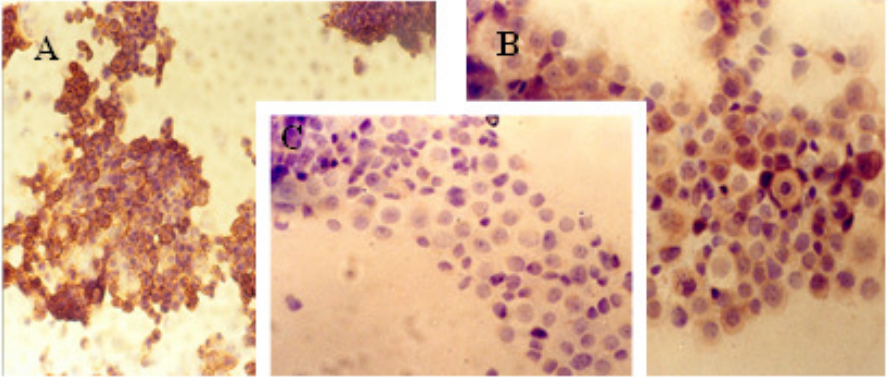
Figure 5. Immunocytochemical study with peroxidase staining of MCF-7 and MCF-7TG cells. Analysis of c-erbB-2 oncogene expression in: A, parental MCF-7cells; B and C, MCF-7TG cells induced with dexamethasone (1 mM) for 2 and 6 days, respectively. (A, X 200 magnification; B and C, X 400 magnification)